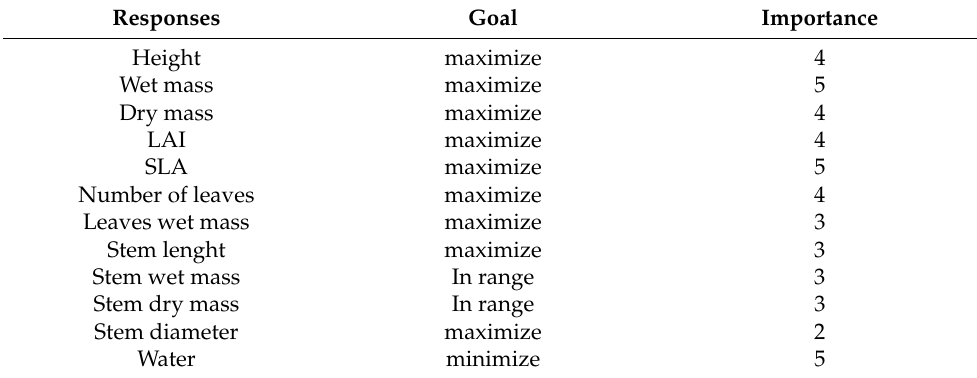
Table 10. Desirability function